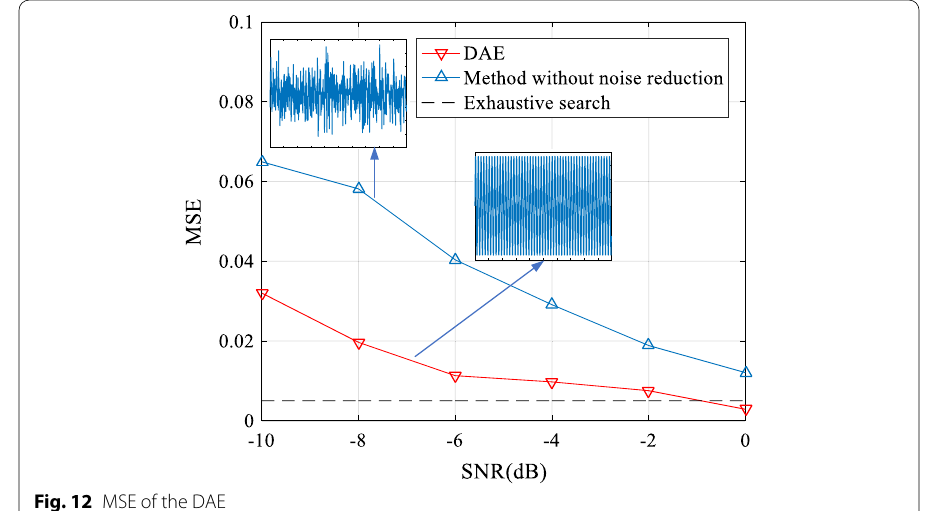
Fig. 12 MSE of the